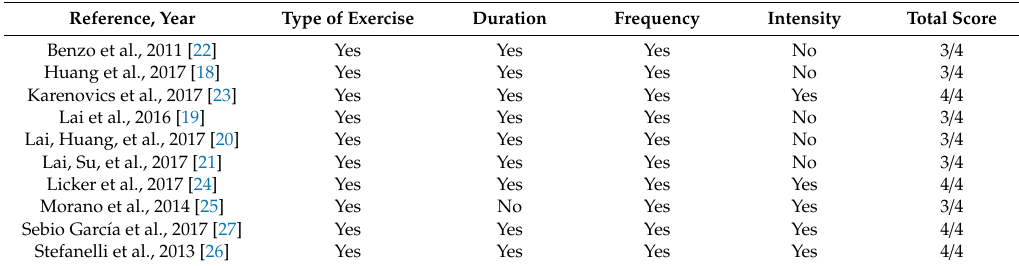
Table 2. Analysis of preoperatory exercise training interventions.